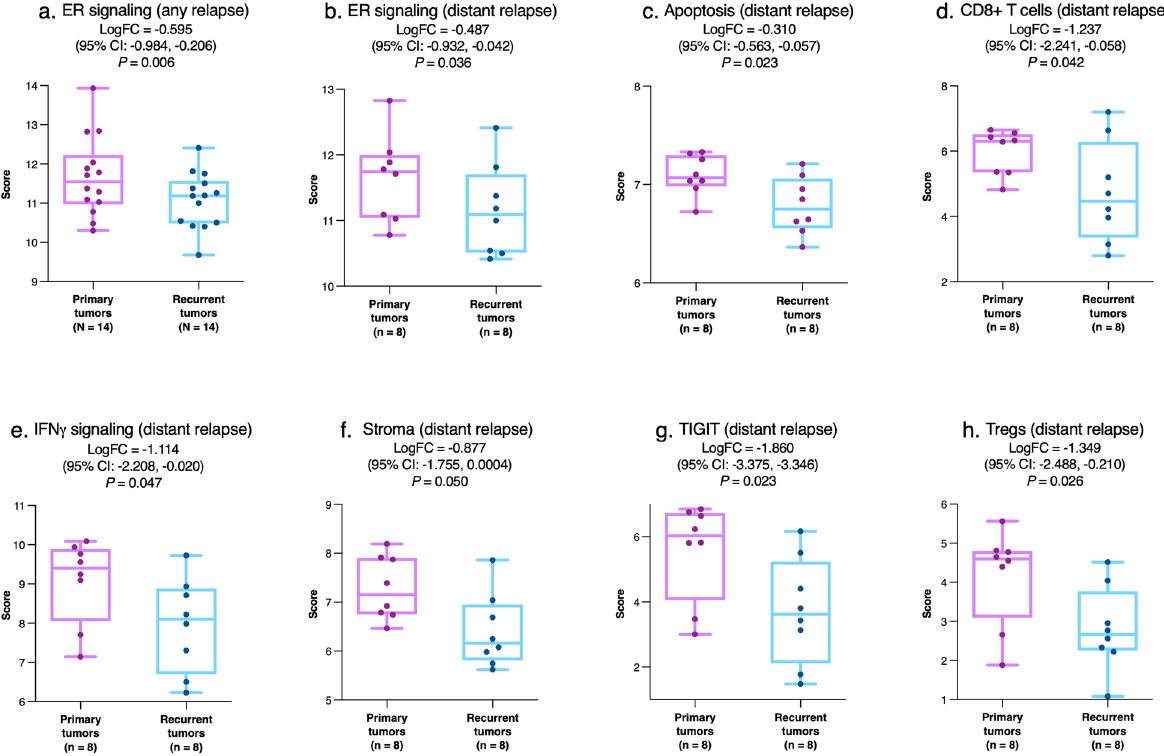
Fig. 5 Intraindividual comparison of gene expression between matched primary tumors and post-pCR recurrences. Data are shown for ER signaling ( a , b ), apoptosis ( c ), CD8 + T cells ( d ), IFN γ signaling ( e ), stroma ( f ), TIGIT ( g ), and Treg ( h ) signature expression for the overall cohort ( a ) and for the distant relapse subgroup ( b – h ). The central line indicates the median, the box indicates the 25th and 75th percentiles and the whiskers indicate the range. Circles represent individual data points. Negative values for logFC indicate lower expression in recurrent versus primary tumors. Abbreviations: CI con fi dence interval, ER estrogen receptor, IFN- γ interferon gamma, logFC log 2 -fold change, TIGIT T-cell immunoreceptor with Ig and ITIM domains, Tregs regulatory